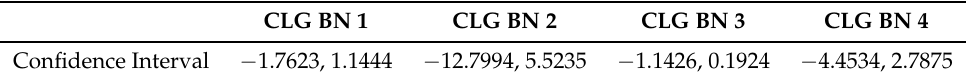
Table 5. Confidence intervals from paired t-tests between the optimal settings and the default settings with nc = 1 and it = 10.